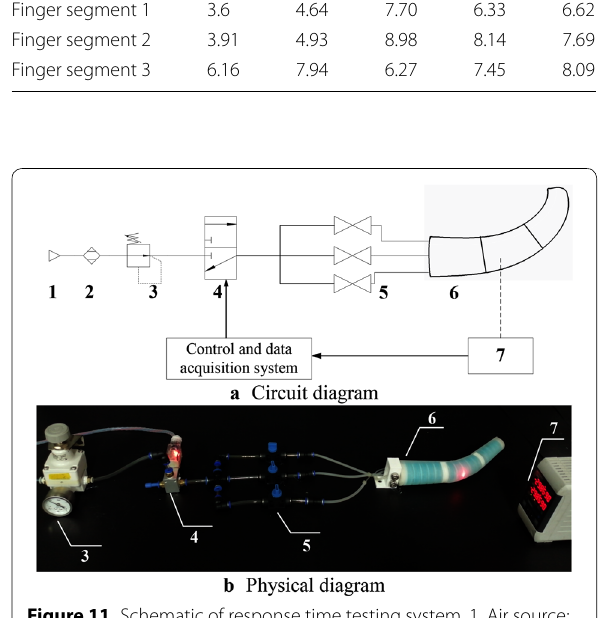
Figure 11 Schematic of response time testing system. 1. Air source; 2. Dryer; 3. Reducing valve; 4. Solenoid directional valve; 5. Shut-off valve; 6. Finger; 7. Laser displacement sensor